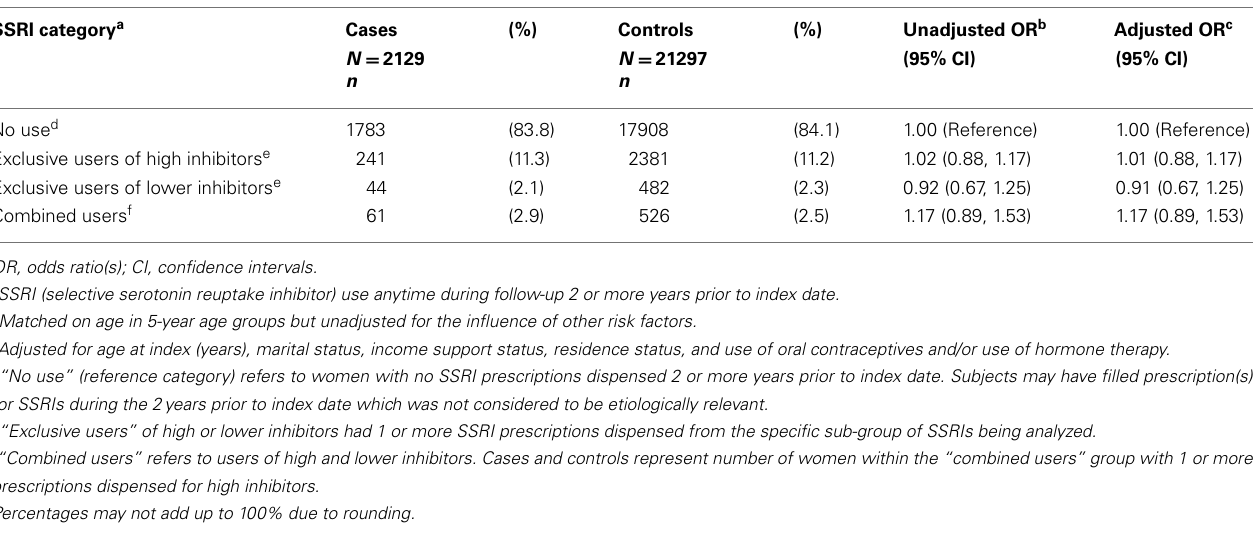
Table 2 | Odds ratios for breast cancer according to the degree of serotonin reuptake inhibition of selective serotonin reuptake inhibitor (SSRI) antidepressants.